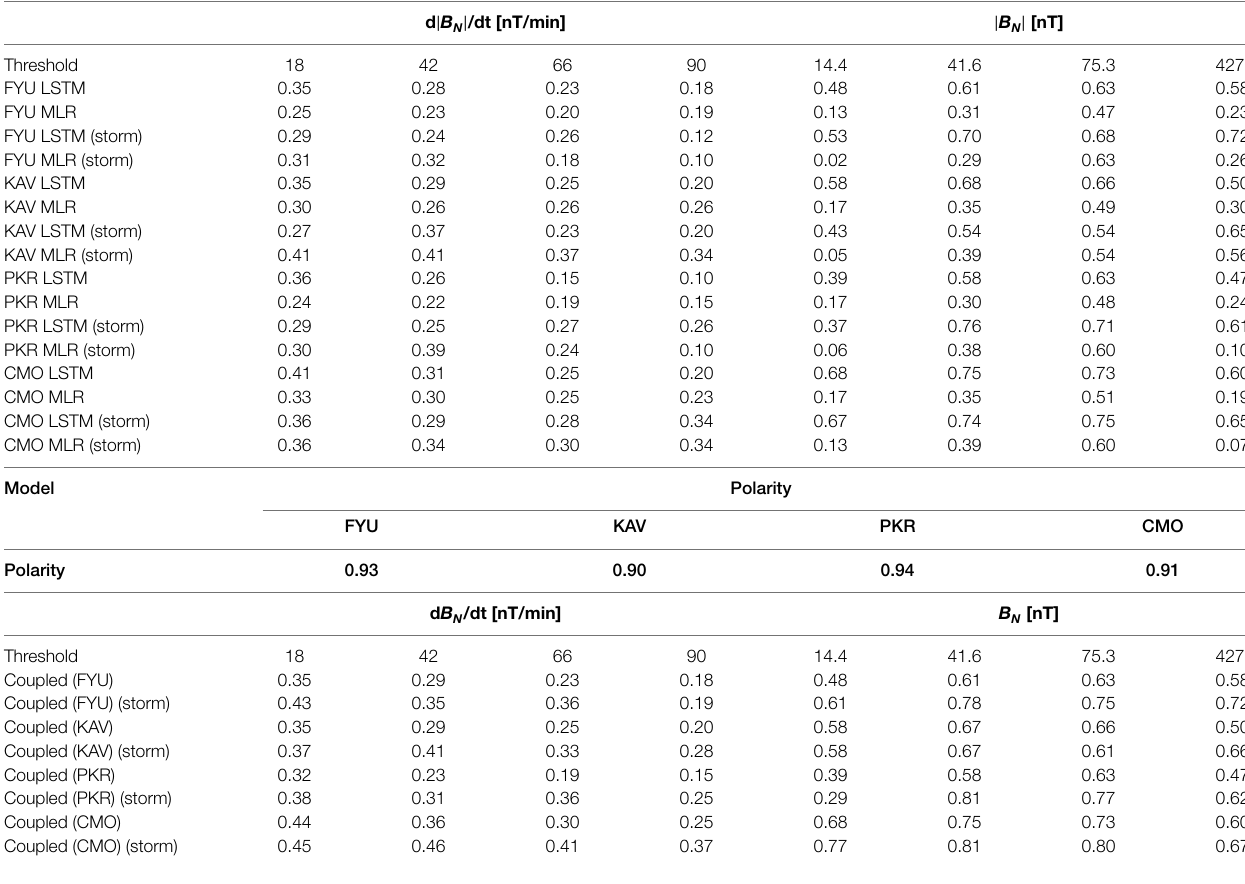
TABLE 1 | HSS of selected | B N | and d | B N | /dt thresholds for the LSTM and MLR models. Scores are evaluated through direct comparison on a minute by minute basis across the year of 2015 and separately for the 07-Sep-2015 storm. Polarity has been encoded into a value of 0 (−) or 1 (+) and the HSS for this corresponds to accurately assessing a